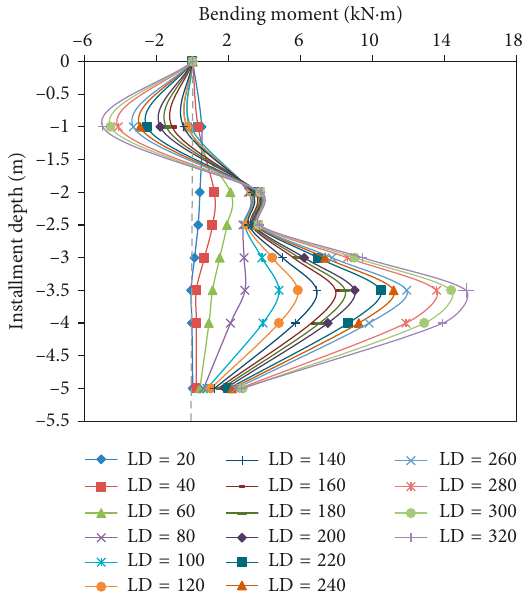
Figure 17: Variation of bending moment with installment depth for Test D No. 3 (loading displacement short for